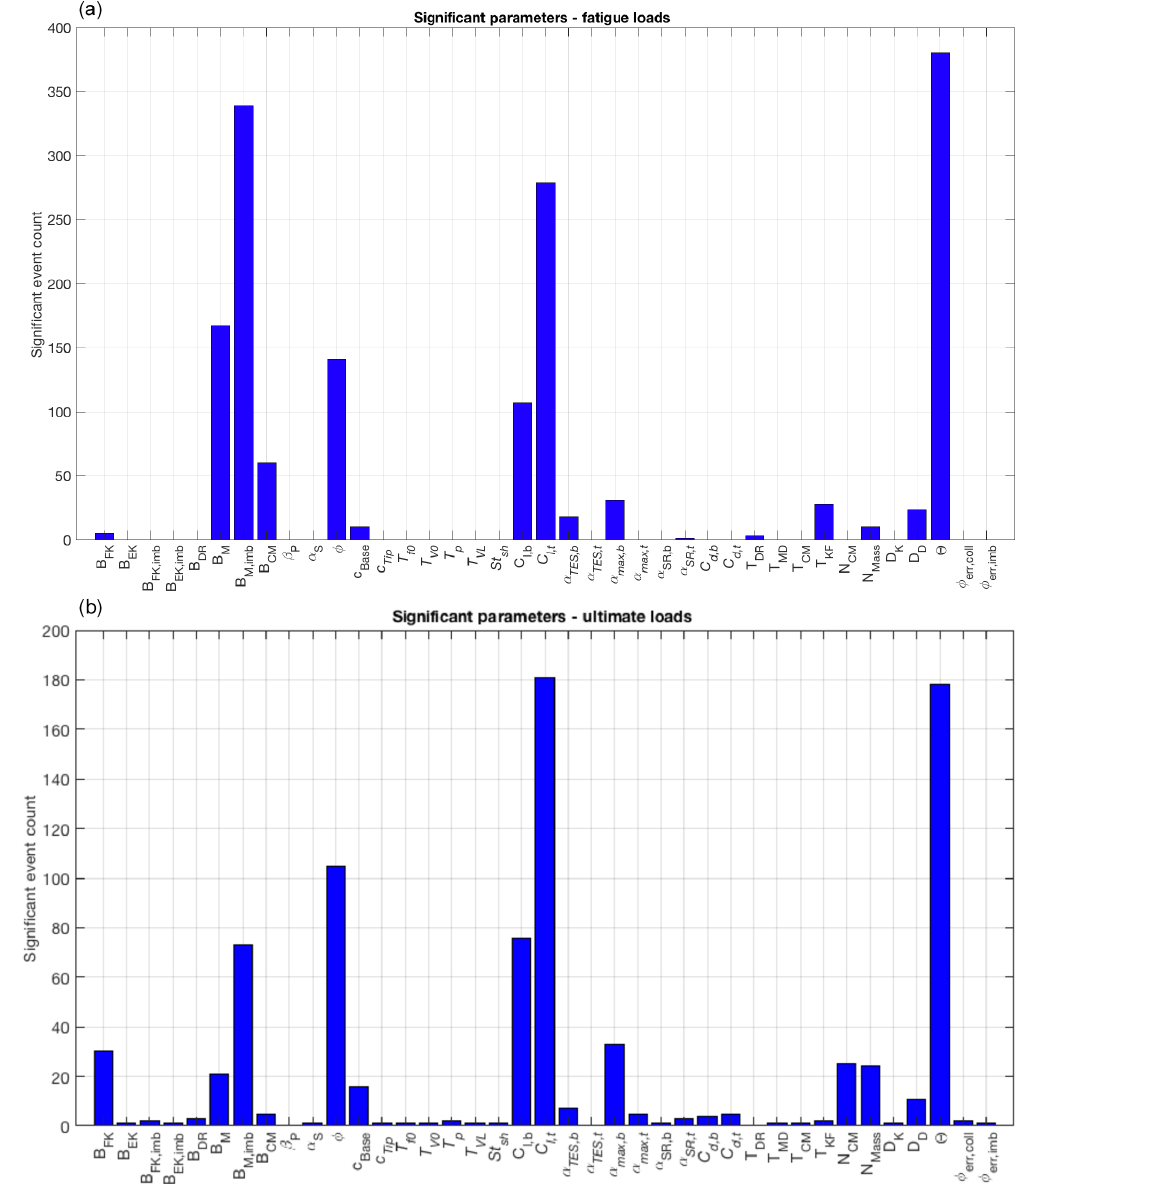
Figure 11. Identification of significant parameters using (a) ultimate and (b) fatigue loads. Significant events are defined by the number of outliers identified across each of the QoIs for all wind speed bins, input parameters, and simulation